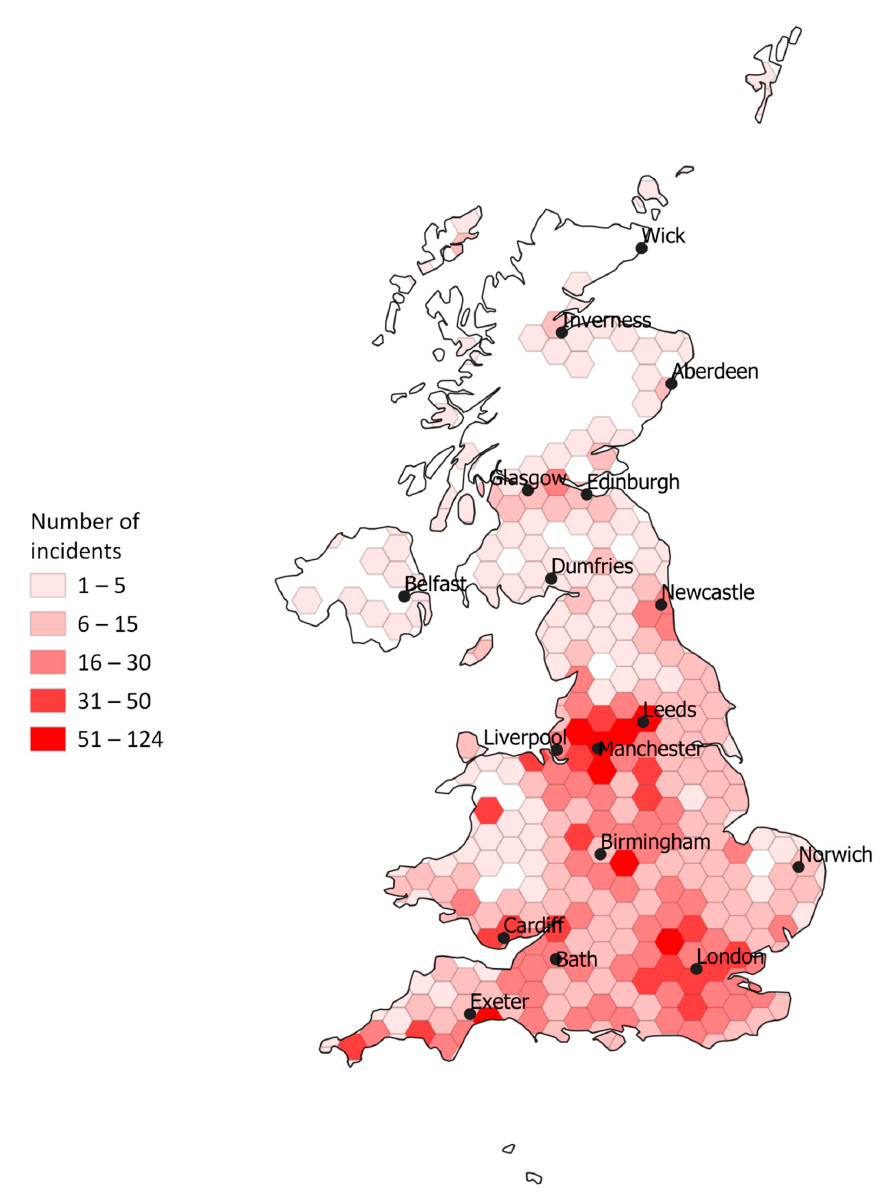
Figure 1. Choropleth map of all horse-related road incidents reported to the British Horse Society across the United Kingdom (UK) between 2010 and 2020. Major UK cities and towns are labelled.